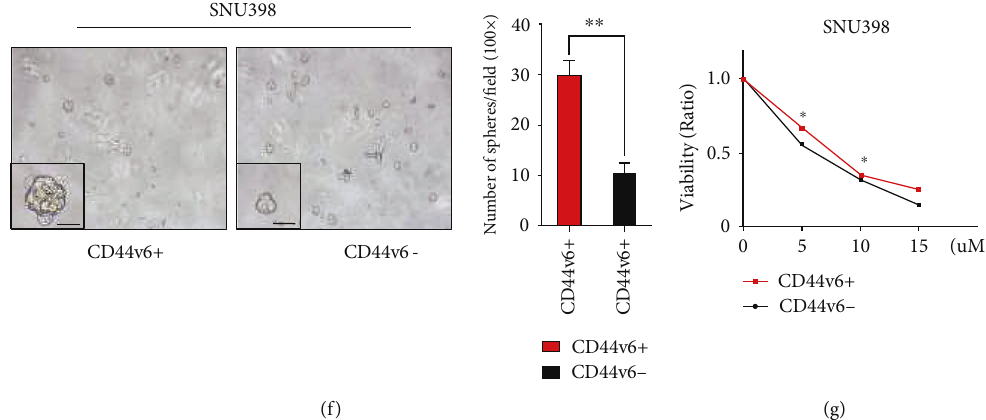
Figure 1: CD44v6+ HCC cells possess stemness properties. (a) CD44v6 negative/positive SNU398 cells were subcutaneously injected into the BALB/c mice. Red arrow means CD44v6 positive group, black arrow means negative group. The tumor volume from each group were tested. For statistical analysis, ∗ p < 0 : 05 , ∗∗ p < 0 : 01 , t -test. The representative images of IHC staining of CD44v6 and Ki67 in CD44v6 positive and negative group tumor tissues. Bars: 200 μ m. (b) The liver and the lung of the SNU398 cell subcutaneously treated mice were dissected. Red circle indicates the site of metastatic tumor. Hematoxylin-eosin (HE) staining showed the metastatic tumor in the liver. (c) Representative images of transwell migration and invasion in indicated cells. Scale bar, 200 μ m. ∗∗ p < 0 : 01 , t -test. (d) The colony formation assay showed that the colony formation ability of CD44v6+ cells was stronger than CD44v6- cells. ∗∗ p < 0 : 01 , t -test. (e) CCK8 assay showed the cell proliferation in CD44v6+ cells was stronger than CD44v6- cells. ∗ p < 0 : 05 , ∗∗∗ p < 0 : 001 , t -test. (f) The representative images of spheres and histogram analysis in indicated cells. Scale bar, 200 μ m. ∗∗ p < 0 : 01 , t -test. (g) Cell viability assay was performed using CCK8 assay in SNU398 cells, which were treated with indicated concentrations of sorafenib for 24 hours. And the number of viable cells represented the susceptibility of the CD44v6+ cells to antisorafenib. ∗ p < 0 : 05 , t 176 : 7 ± 35 : 31 /HP, ∗ p < 0 : 05 , t -test). Together, our data dem-